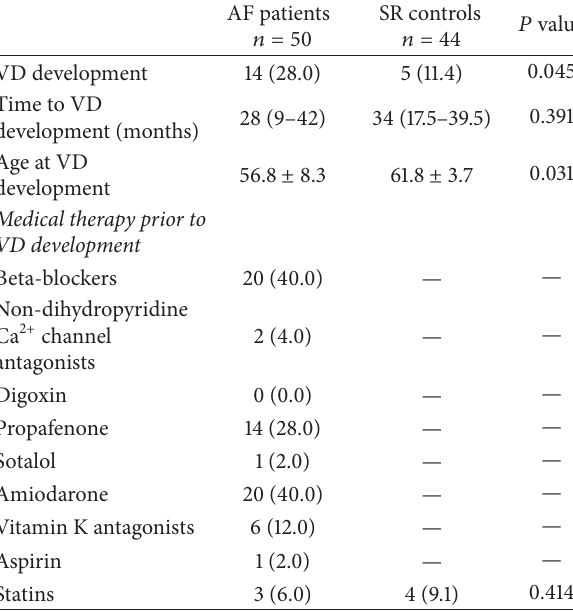
Table 2: Development of vascular disease in lone AF patients and healthy controls.